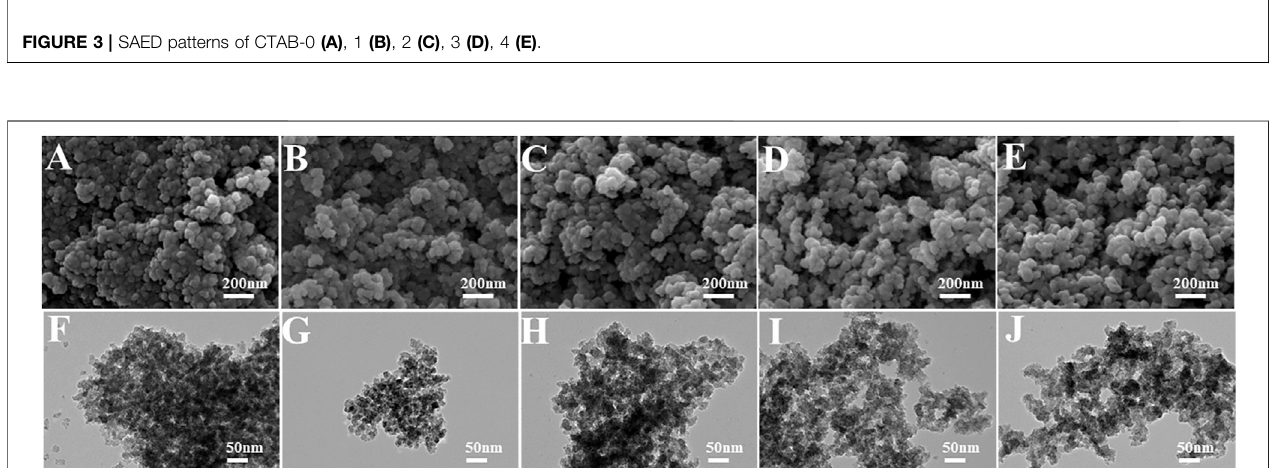
Figure S3 . Based on the BJH (Barrett – Joyner – Halenda model) analysis on the desorption curves, their pore-size distributions are